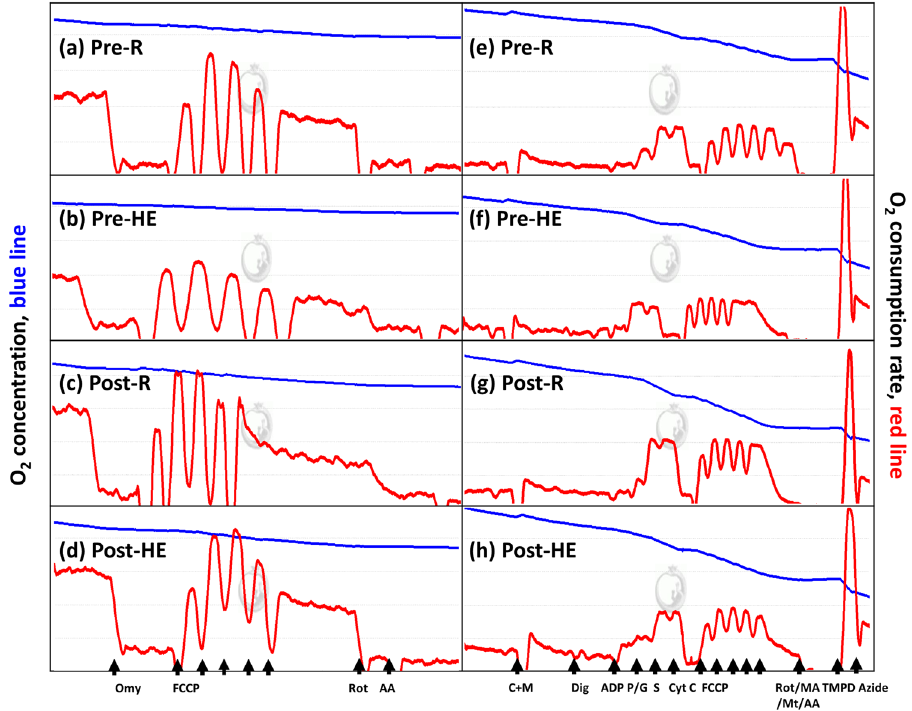
Figure 3. Graph showing measurement of mitochondrial O 2 consumption rate (OCR) in platelets using a high-resolution respirometry (Oroboros O2K). (a–d) , the OCR protocol in intact platelets; (e–h) , the OCR [substrate, uncoupler, inhibitor titration (SUIT)] protocol in permeabilized platelets. Omy , oligomycin; FCCP , carbonyl cyanide-p-trifluoromethoxyphenylhydrazone; Rot , rotenone; AA , antimycin A; M , malate; C , palmitoyl-DL carnitine-HCl; Dig , digitonin; ADP , adenosine diphosphate; P , pyruvate; G , glutamate; S , succinate; Cyst C , cytochrome c; MA , malonic acid; Mt , myxothiazol. Pre , before high-intensity interval training (HIT); Post , after HIT; R , resting; HE , hypoxic (12%O 2 ) exercise